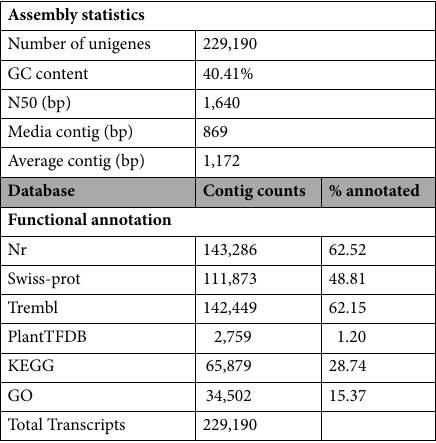
Table 1. Transcriptome assembly summary statistics. Annotation carried out with BlastX and cut-off at